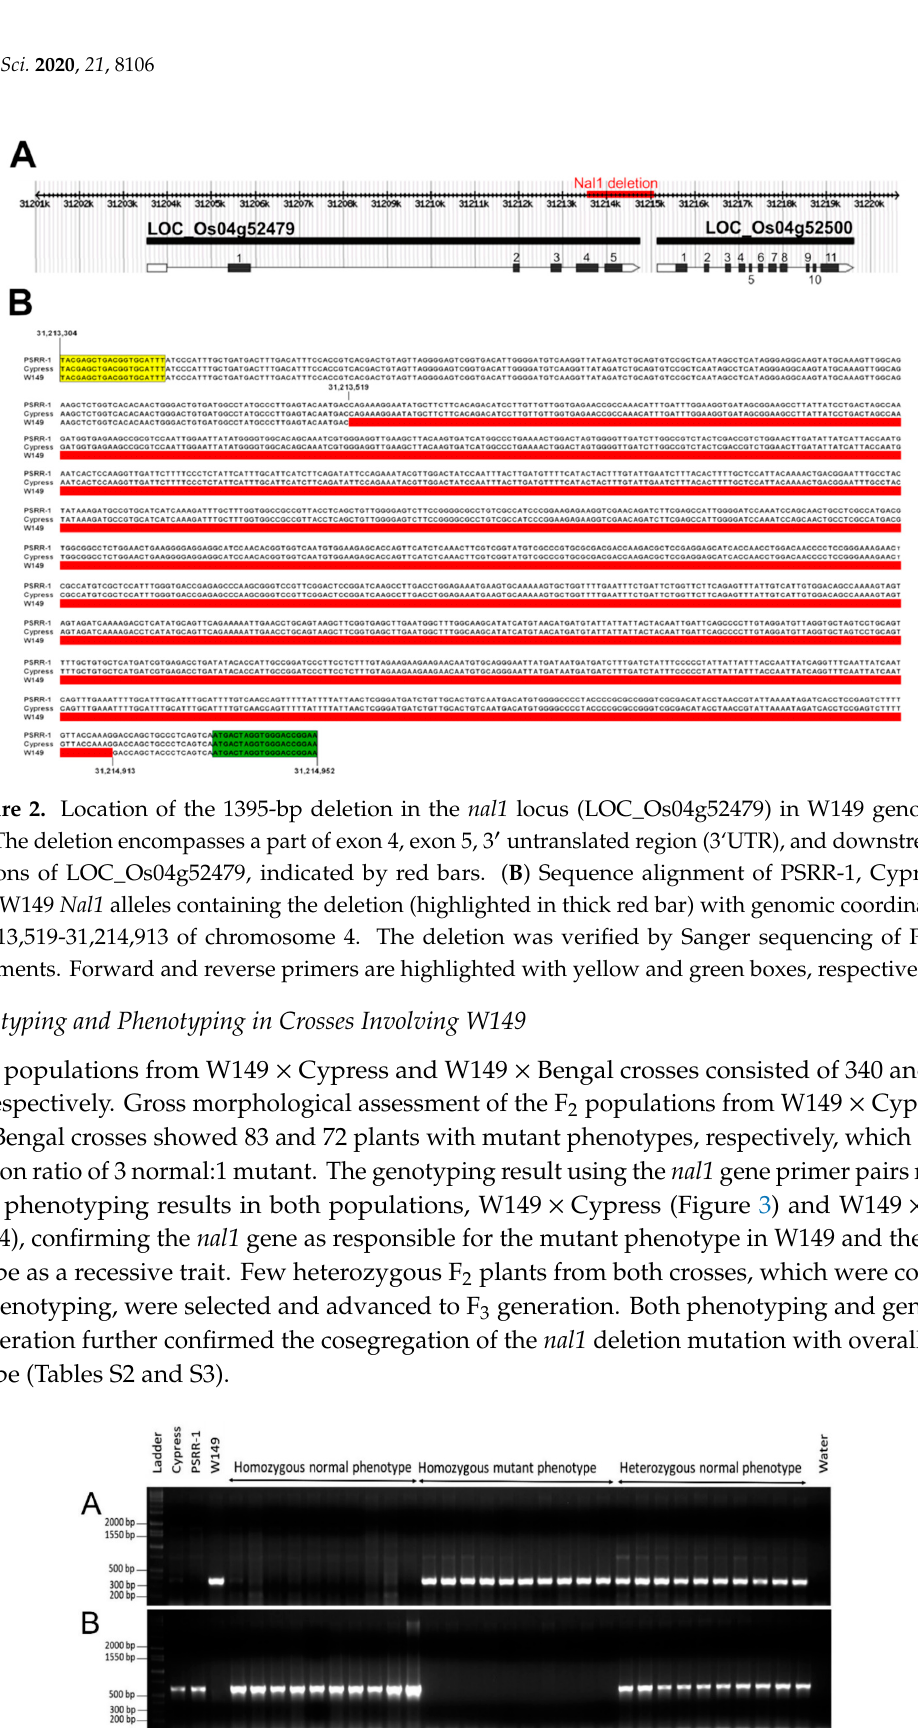
Figure 3. Genotyping of representative F 2 progenies of the cross W149 × Cypress to distinguish homozygous normal, heterozygous normal, and homozygous mutant plants. ( A ) PCR amplification by the Primer pair 1 (1F and 1R); ( B ) PCR amplification by the Primer pair 3 (2F and